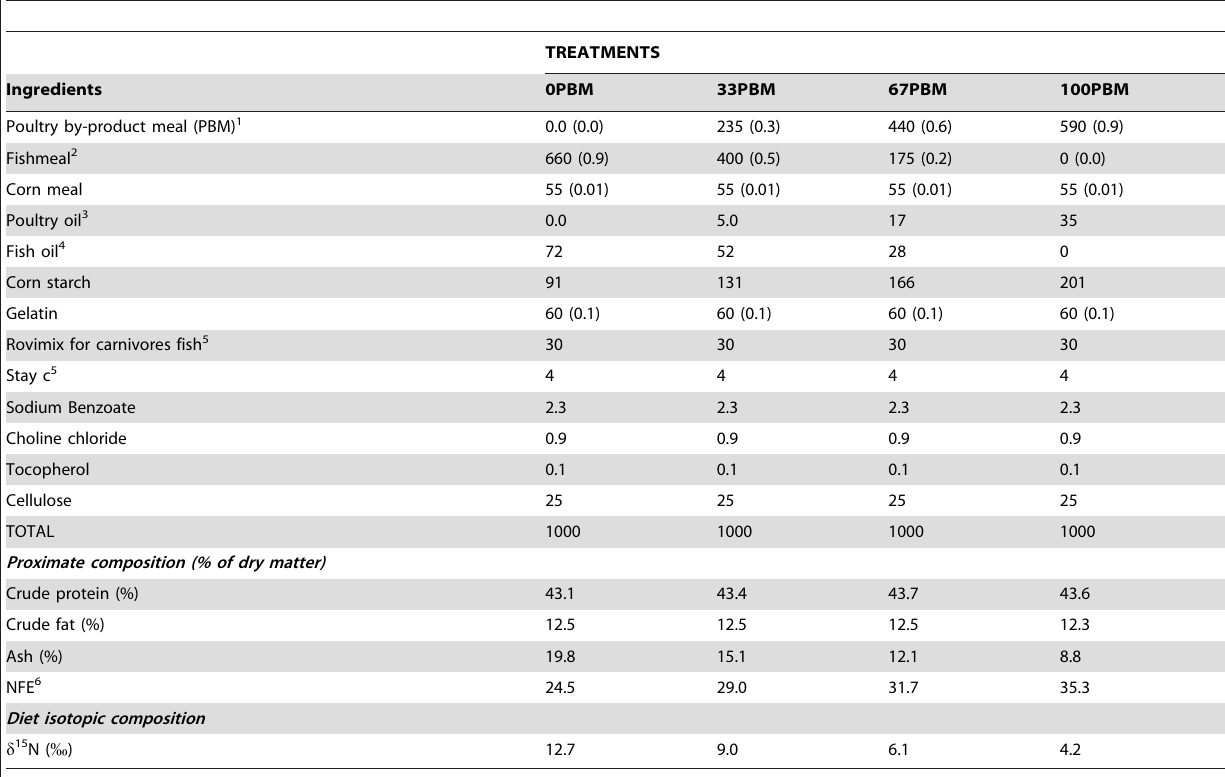
Table 1. Ingredients (g per Kg), proximate composition on a dry weight basis (%) and d 15 N values of four experimental diets containing different levels of substitution of fishmeal with poultry by-products meal (PBM; 0, 33, 67 and 100% replacement).